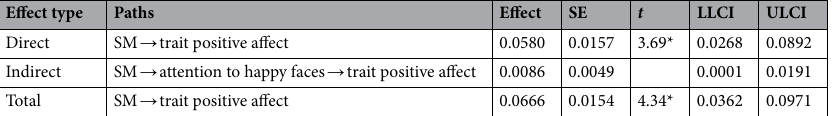
Table 4. Mediation model for the effect of social management on trait positive affect (PANAS) via attention to happy faces (dwell time on happy faces). The HC3 (Davidson-MacKinnon) procedure for heteroscedasticity- consistent inference was used in this analysis. SM, social management; SE, standard error; LLCI, lower limit confidence interval; ULCI, upper limit confidence interval * p <